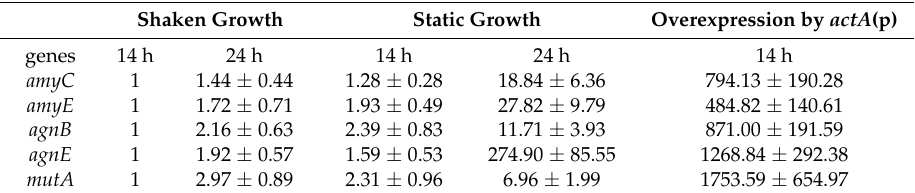
Table 1. Time-course expression study.